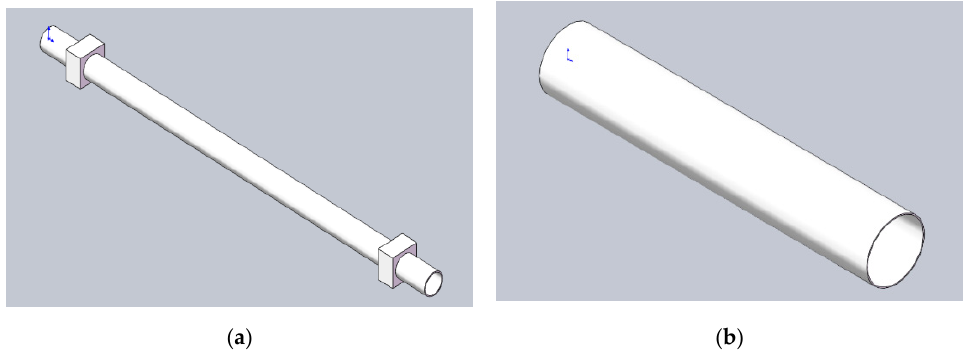
Figure 2. Simplified models of ( a ) an aviation hydraulic pipeline and ( b ) the hard coating.